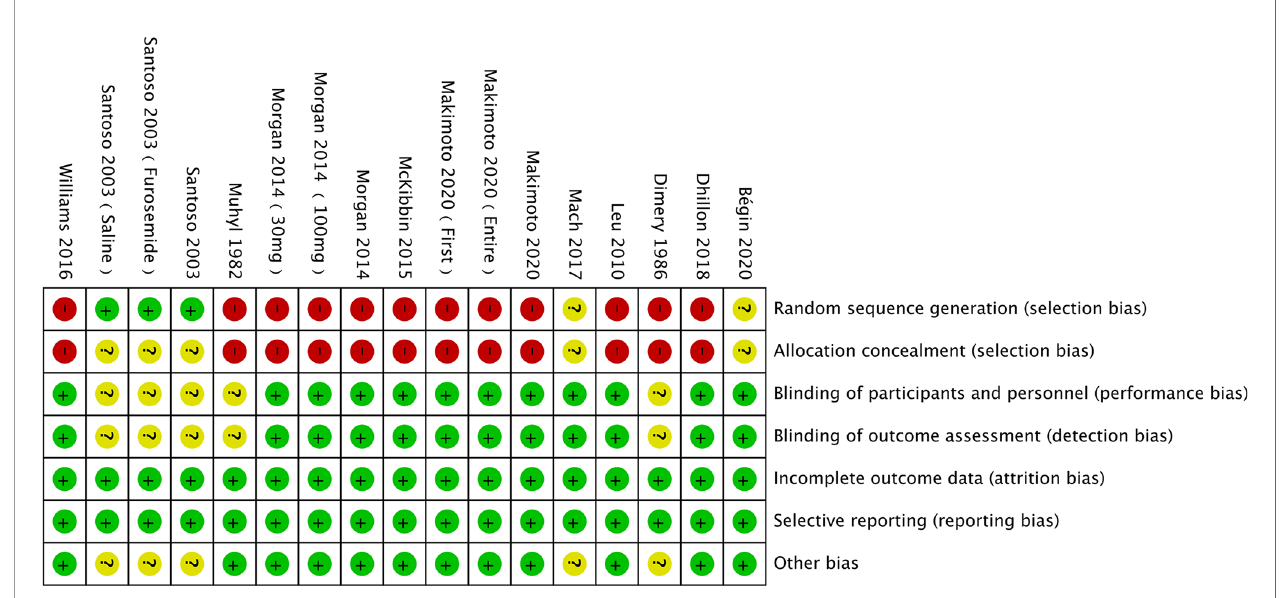
FIGURE 3 | Results of literature quality risk of bias